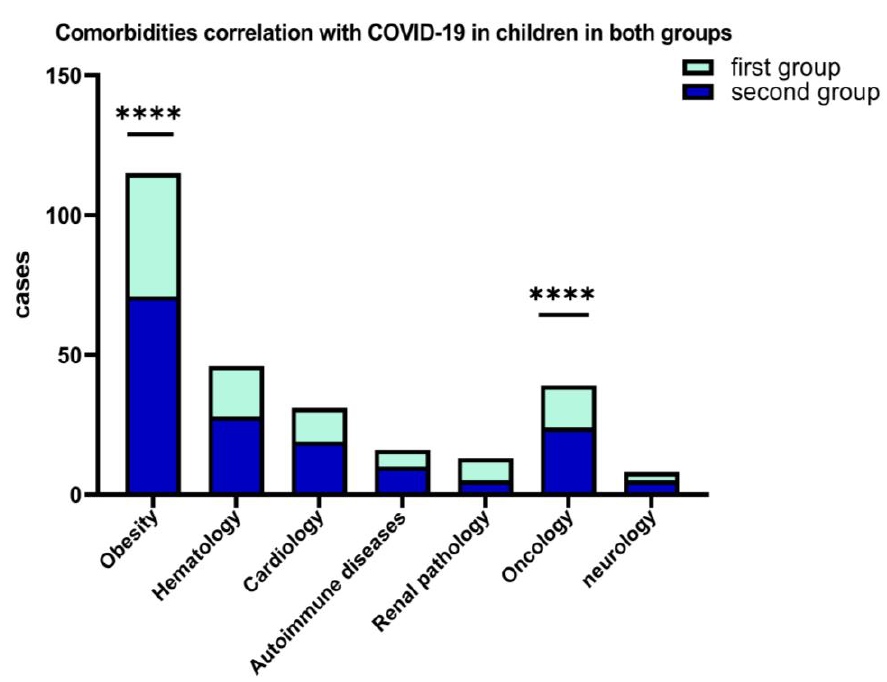
Figure 5. Results of 2-way ANOVA to compare the main effects of the associated COVID-19 comor- bidities (obesity and oncological diseases, ****) in children in both groups.